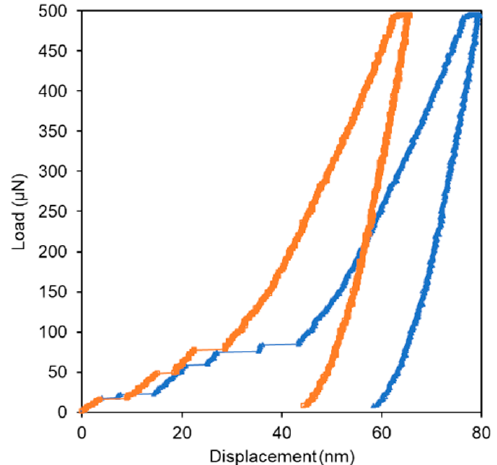
Figure 8. Load–displacement curves showing artificial pop-ins generated at two different times for the same curve.